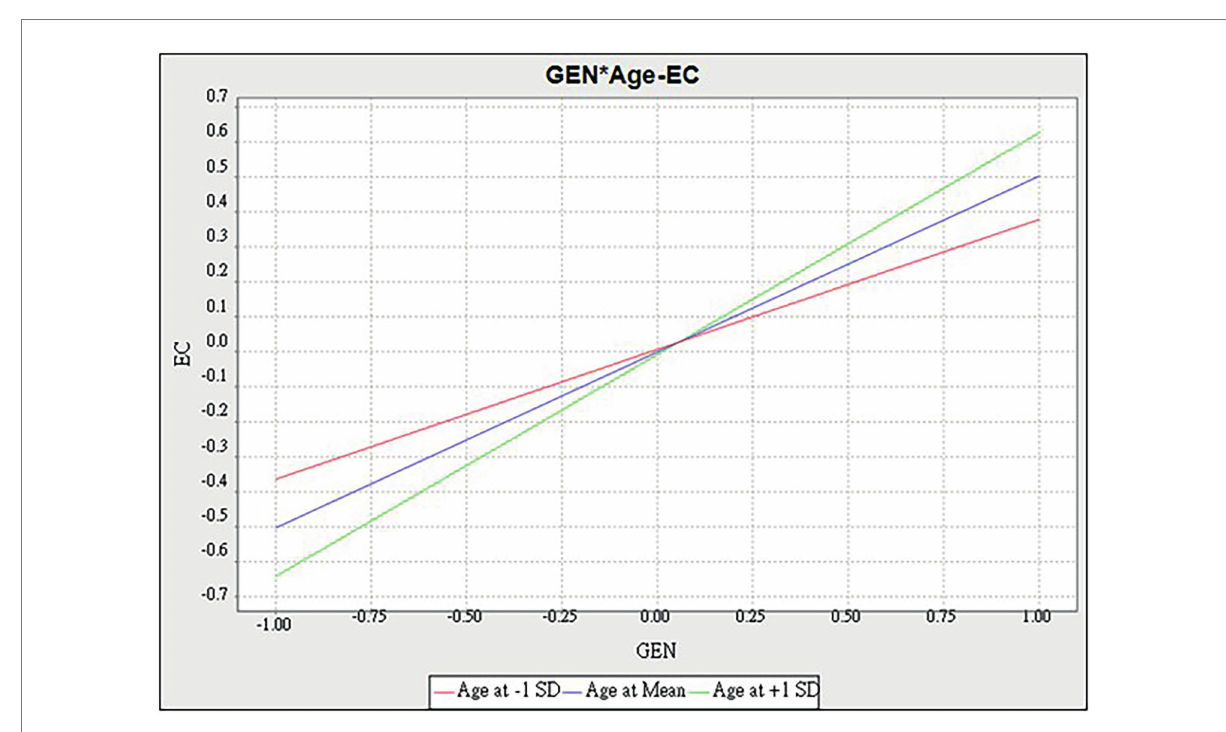
FIGURE 4 Moderating effect of age-generativity to environmental